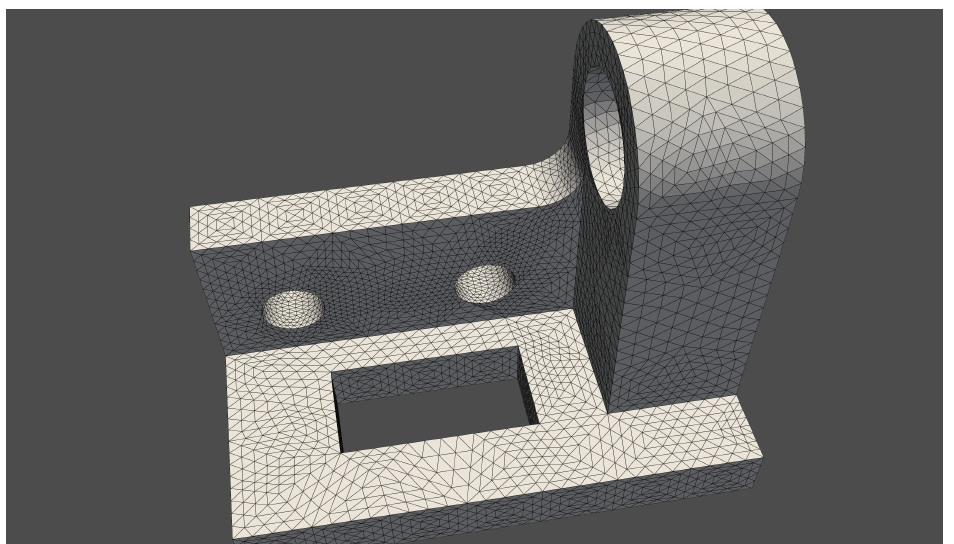
Figure 2. Overhead view of the bracket